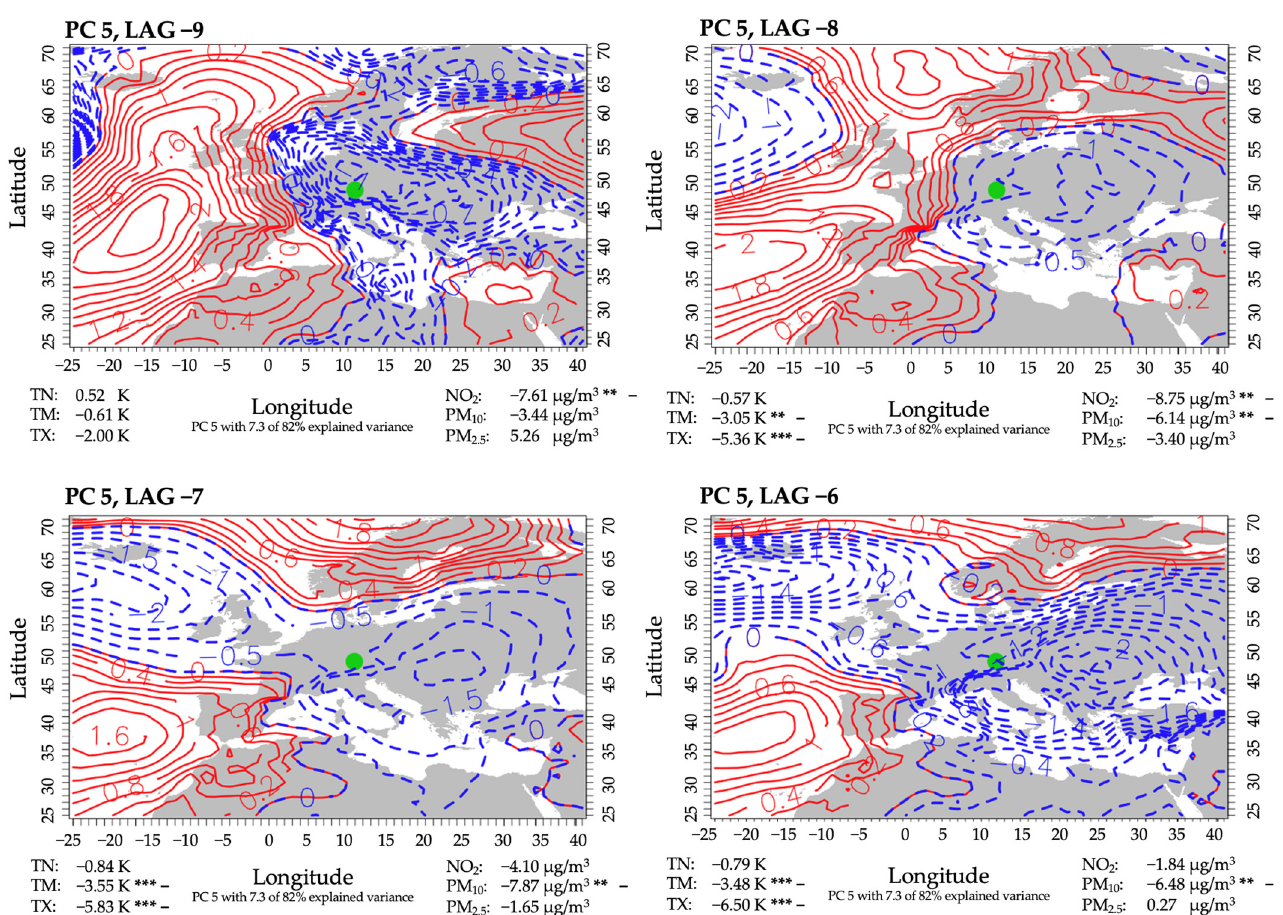
Figure 7. Same as Figure 4, but for PC 5. The level of significance is provided (***: 0.01; **: 0.05; *: 0.1.). The mean difference of all days of the same lag minus the mean of all non-high-mortality-related days, indicated by + or − . + indicates a higher anomaly mean on the corresponding lag days than on non-high-mortality-related days. − indicates a lower anomaly mean on the corresponding lag days than on non-high-mortality-related